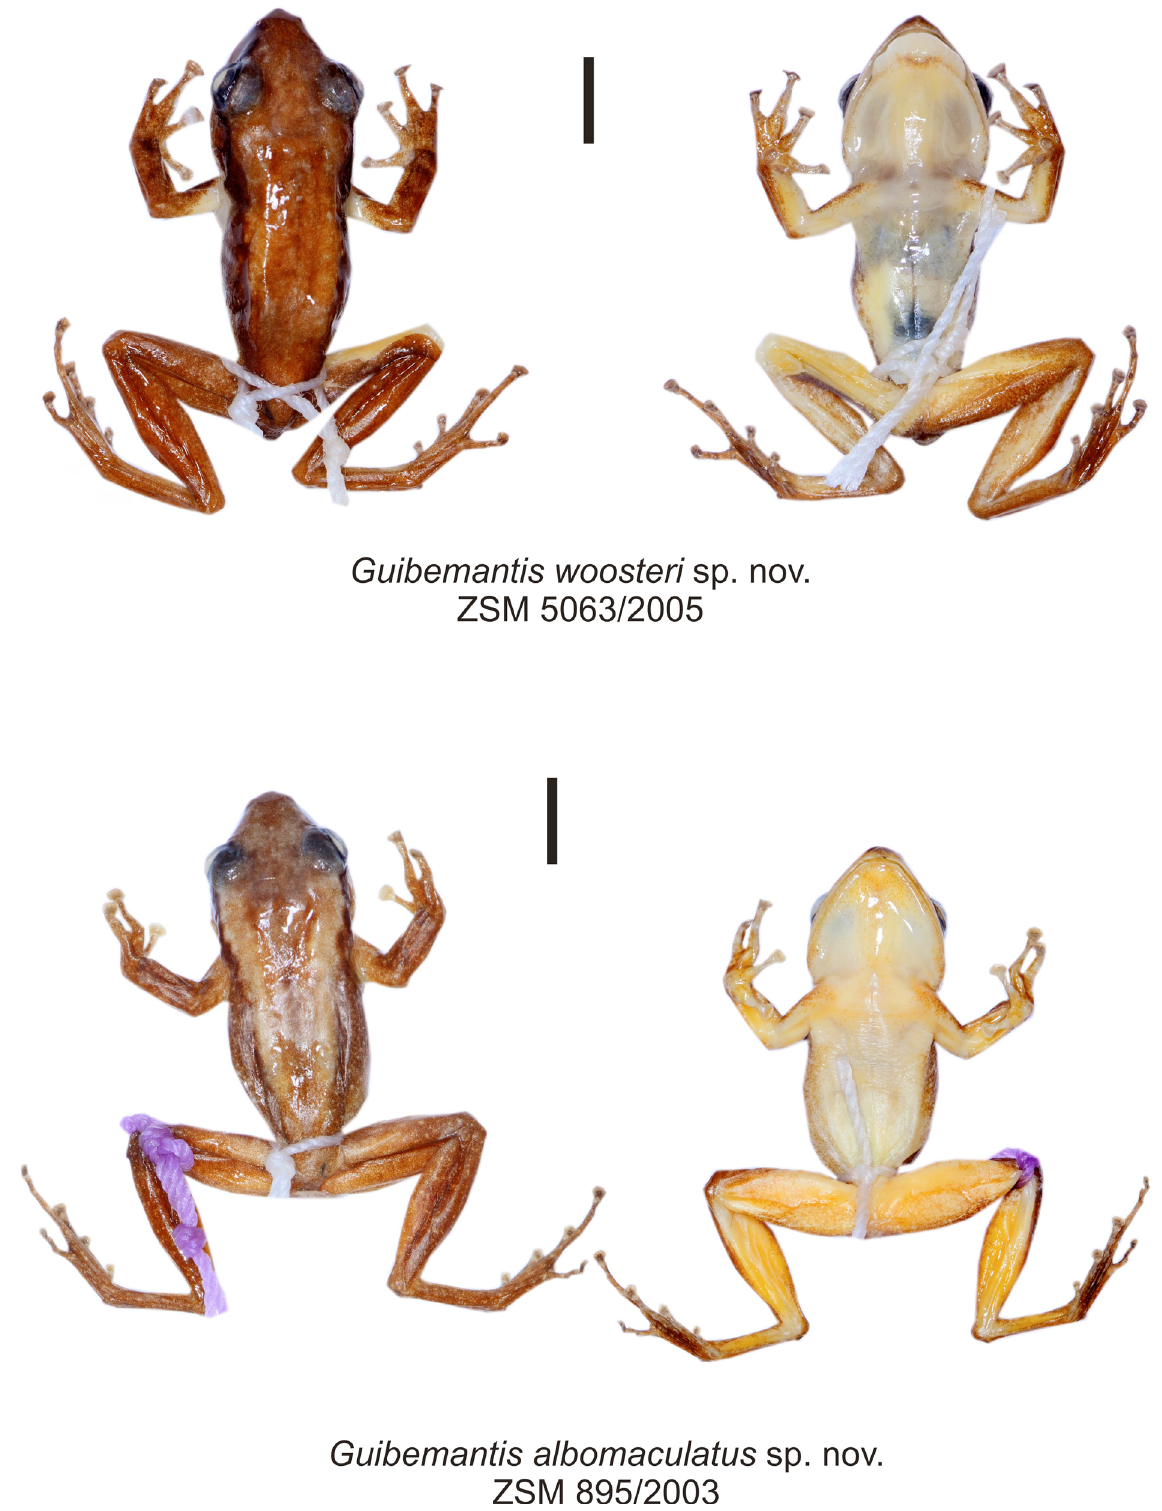
Fig. 3. Preserved holotype specimens of the two new species described herein, Guibemantis woosteri sp. nov. [zSM 5063/2005 (zCMV 2044)] and G. albomaculatus sp. nov. [zSM 0895/2003 (FGMV 2002.905)], in dorsal and ventral view. Scale bars = 5